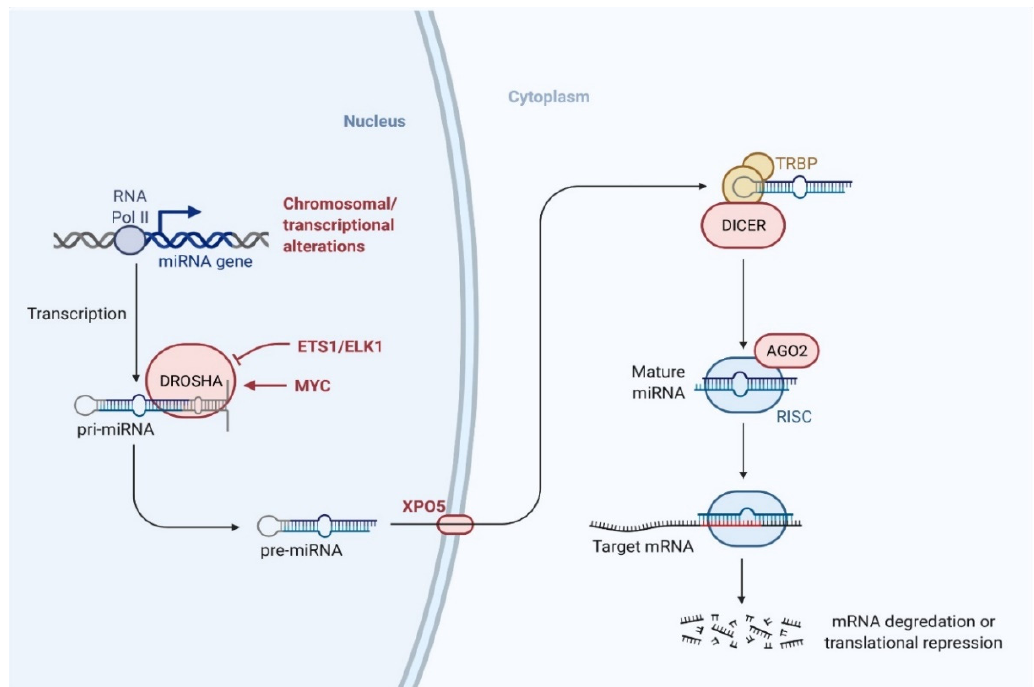
Figure 2. Biogenesis pathway of miRNA. miRNAs are processed by two successive steps in humans: first, in the nucleus by Drosha, followed by Dicer in the cytoplasm. The mature miRNA then binds to the argonaute (AGO) family of proteins to form the core of the RNA-induced silencing complex (RISC) and interacts with the target mRNAs to regulate gene expression. (Created with BioRender.com on 23 July 2021).